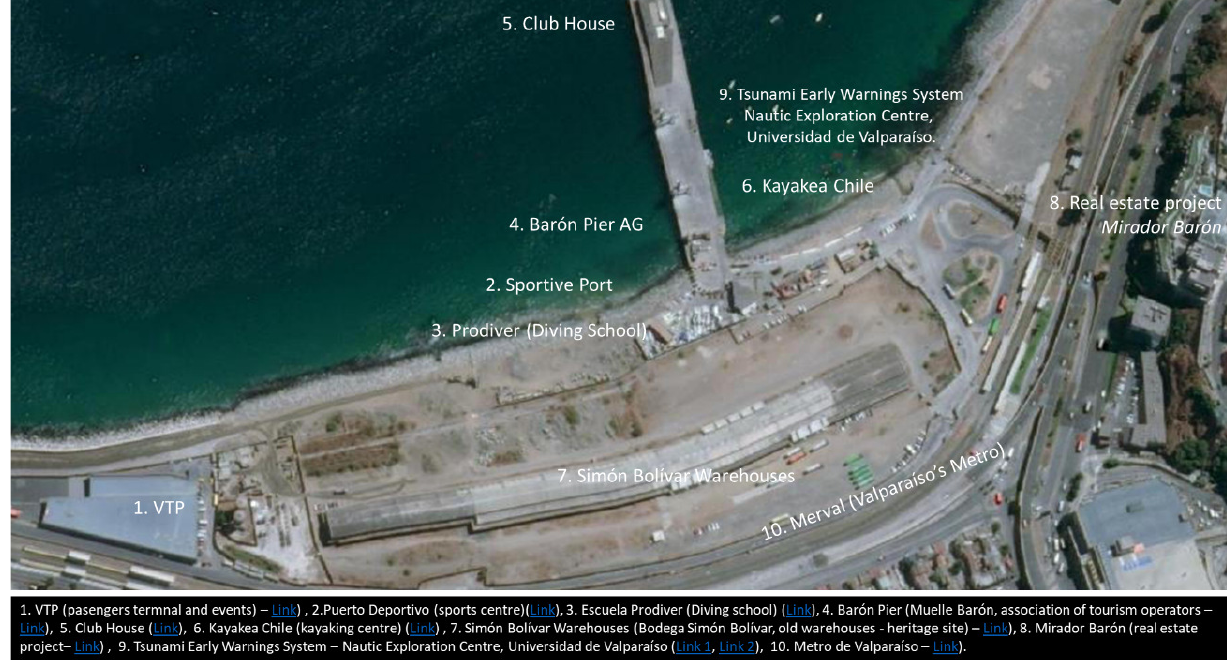
Figure 7. Barón Park (Parque Barón). Source: Own elaboration using Google